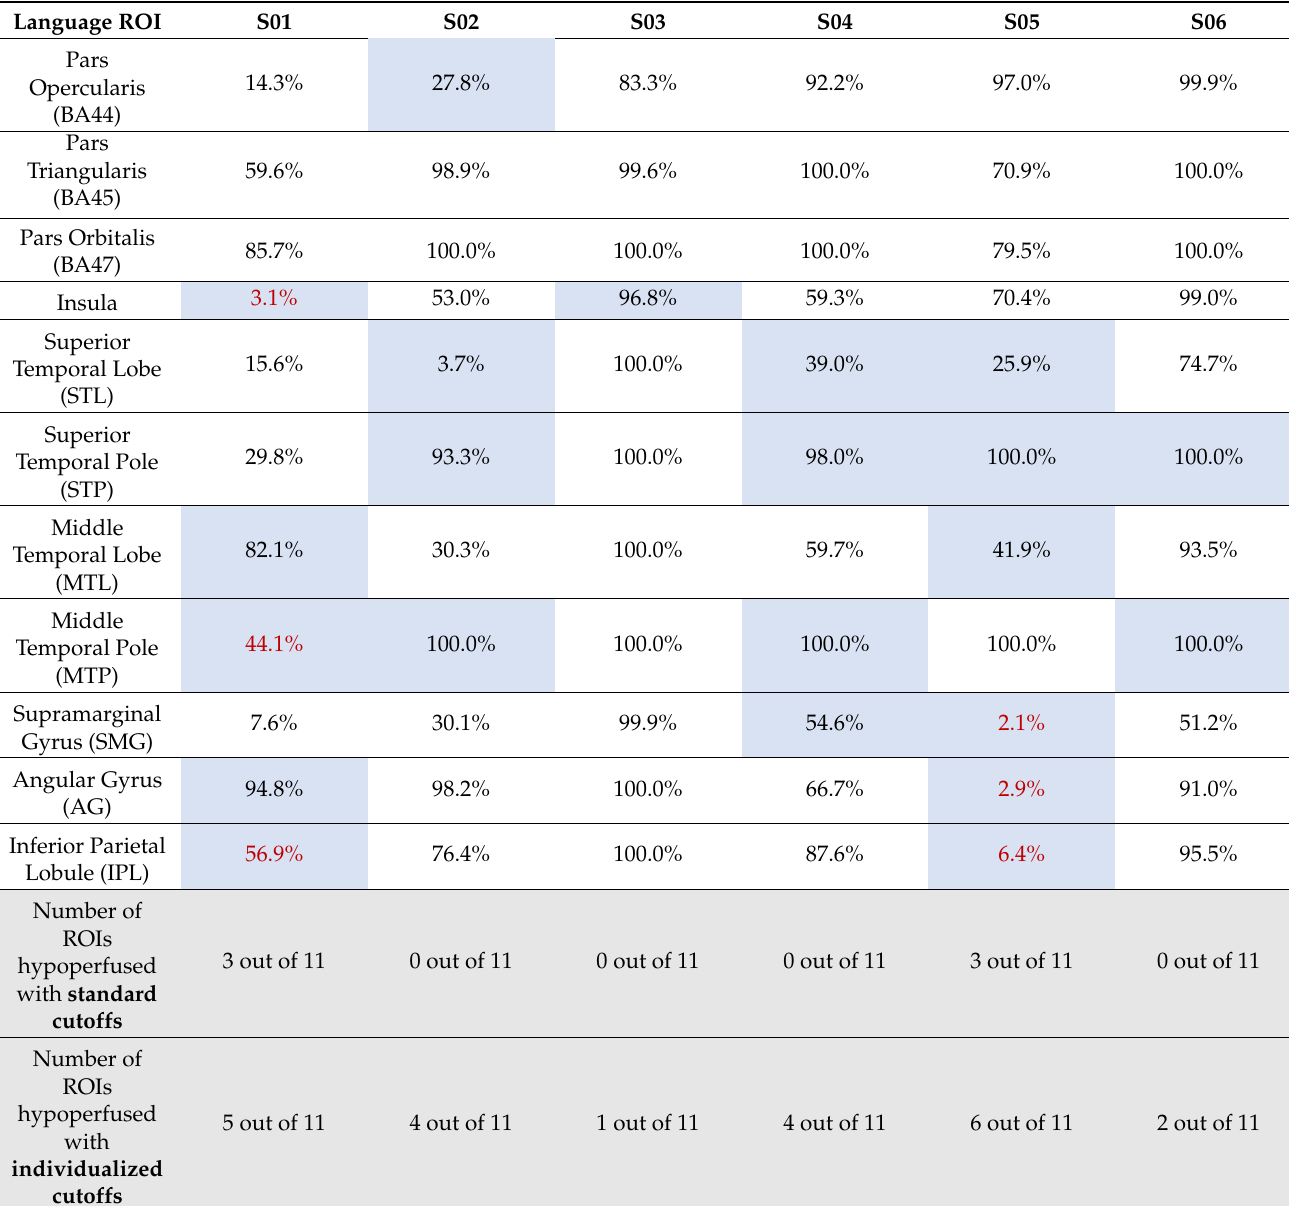
Table 4. A comparison of individualized and standard hypoperfusion approaches in structurally intact brain tissue. Per- centages represent the amount of tissue remaining in each ROI after accounting for the lesion. Blue shading = hypoperfused based on 1.5 standard deviations below mean CBF RH . Red text = hypoperfused based on standard threshold values (<20 mL/100 g tissue/min). The total number of ROIs categorized as hypoperfused using each hypoperfusion metric is reported at the bottom of the